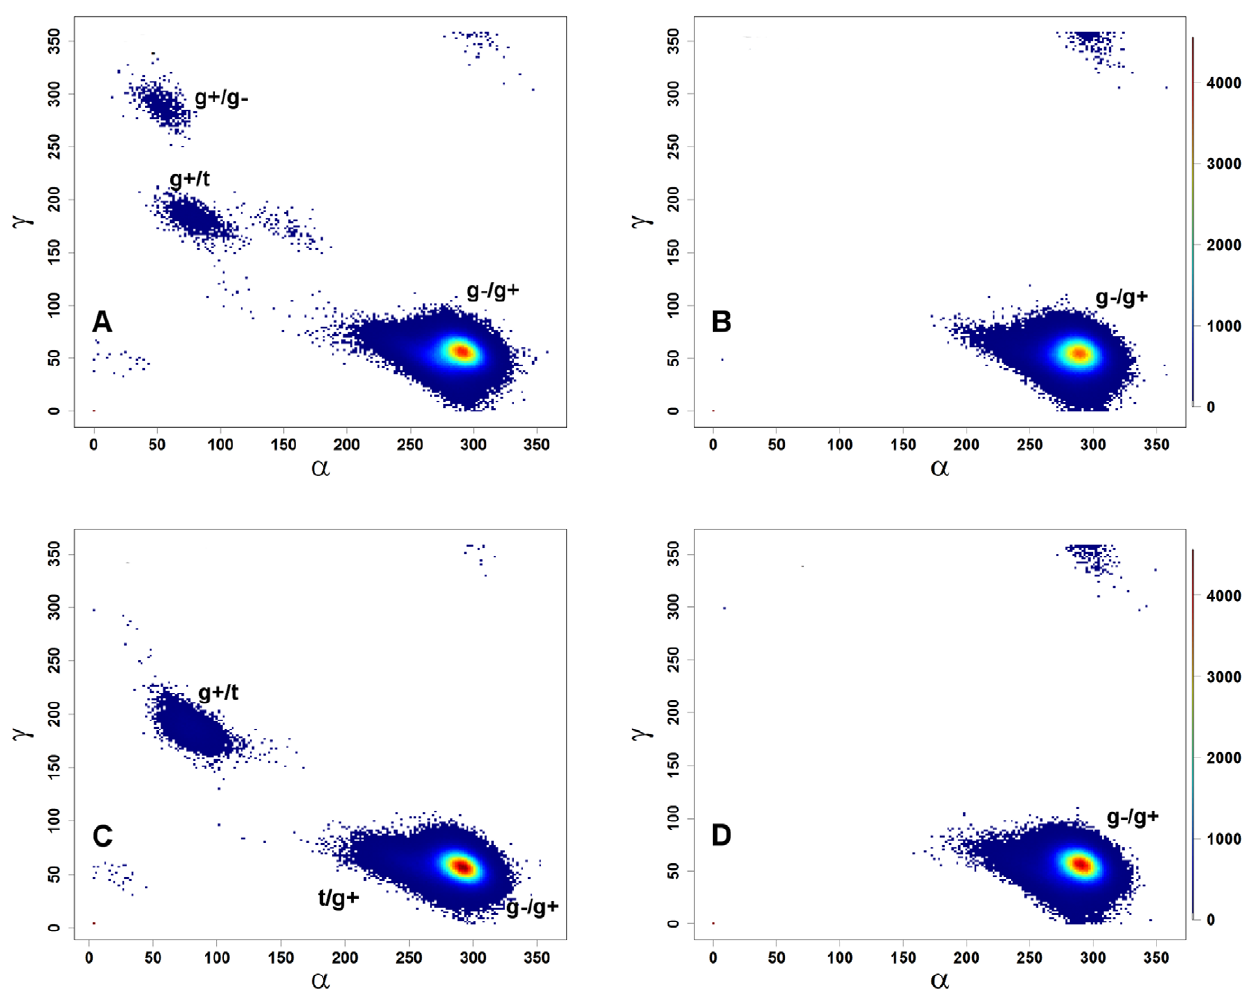
Figure 6. Scatter plots of a vs. c for CpG and GpC steps. (A) GpC steps in B-DNA; (B) CpG steps in B-DNA; (C) Gp5mC steps in 5mCB-DNA; (D) 5mCpG steps in 5mCB-DNA. The plots are color-coded based on the density of points.